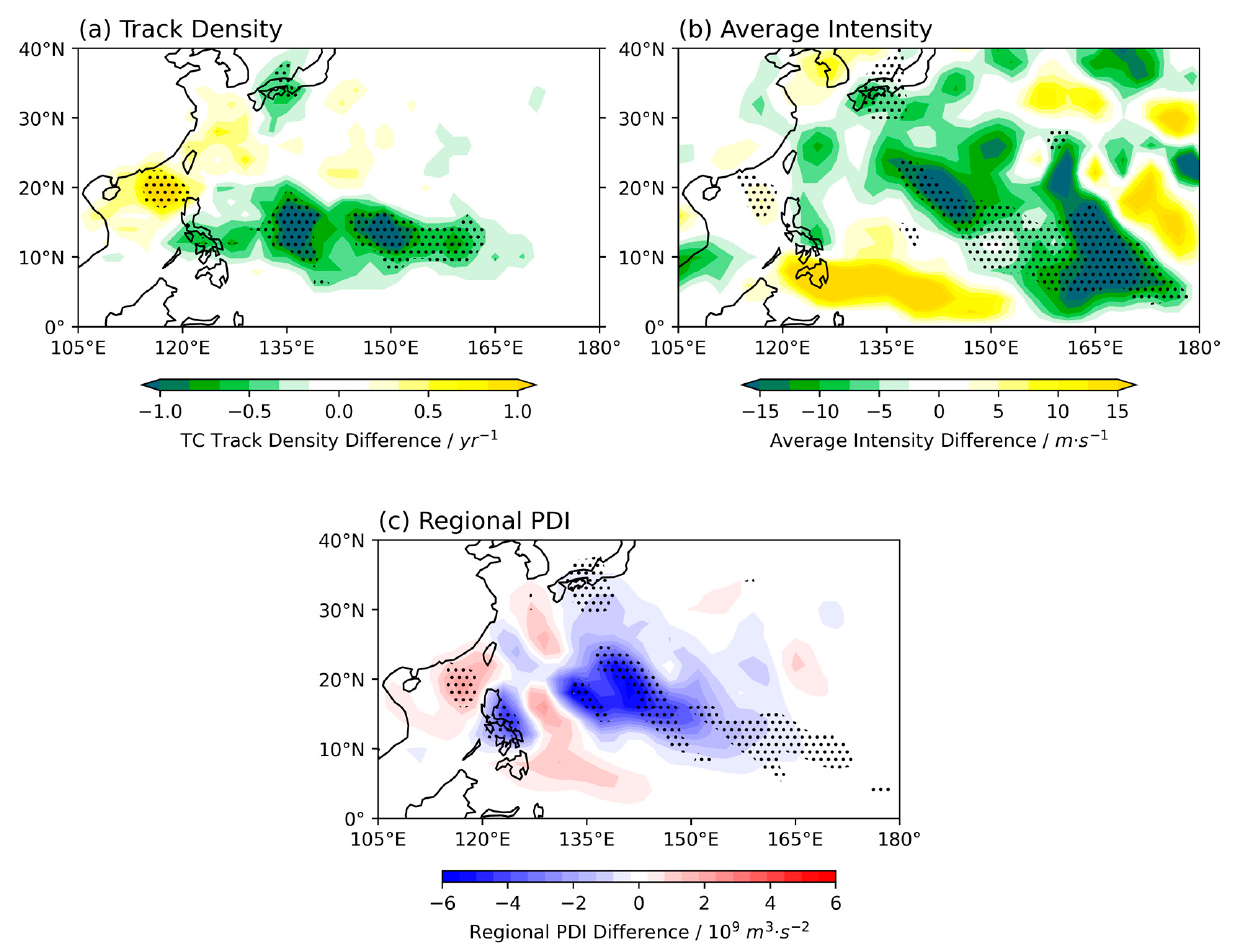
Figure 5. Nine-point-filtered spatial distribution differences (strong SCSSM years minus weak SCSSM years) of ( a ) TCs track density, ( b ) average intensity, and ( c ) regional PDI over WNP basin during TC season. Dots mark areas statistically significant at the 90% confidence level.